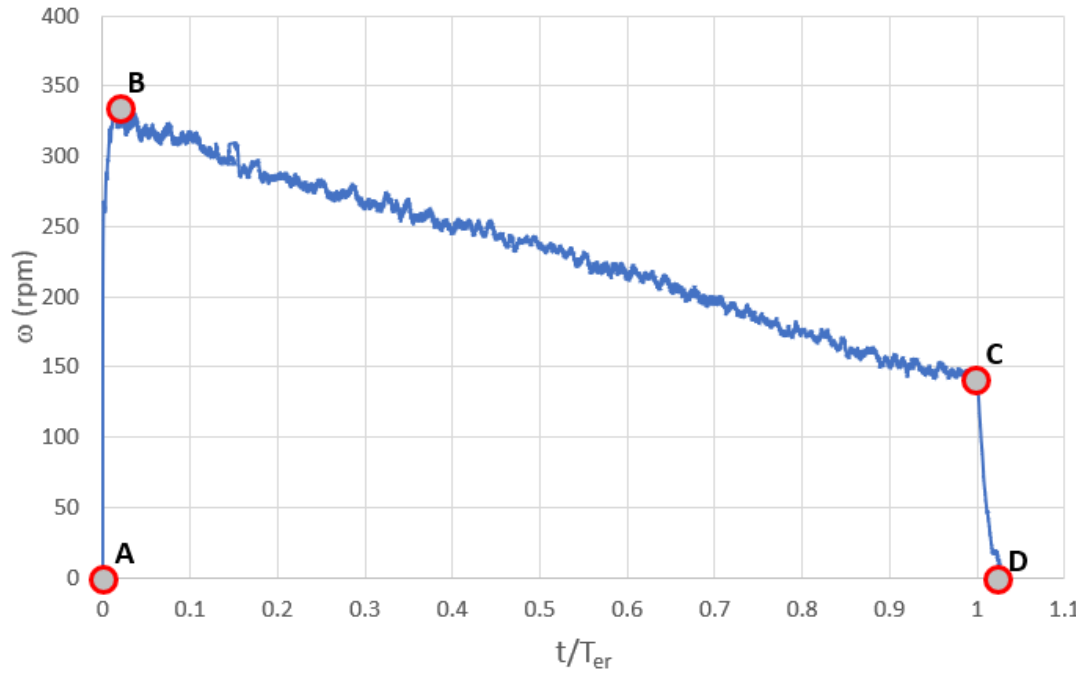
Figure 12. Temporal variation of rotor’s angular speed (base run: run 6).